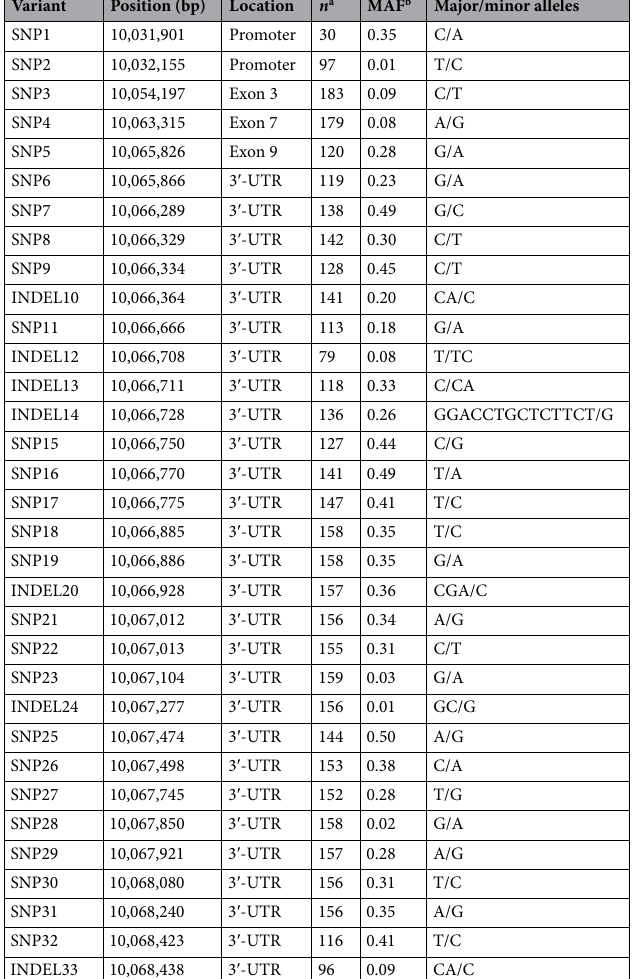
Table 1. Position, alelles and location of the variants identified in the genomic region from SSC9 10,031,627 to 10,068,464 bp, which includes coding region, 3 ′ -untranslated region and 500 bp upstream on the proximal promoter of the DGAT2 gene. a n : Number of animals genotyped. b MAF: Minor allele